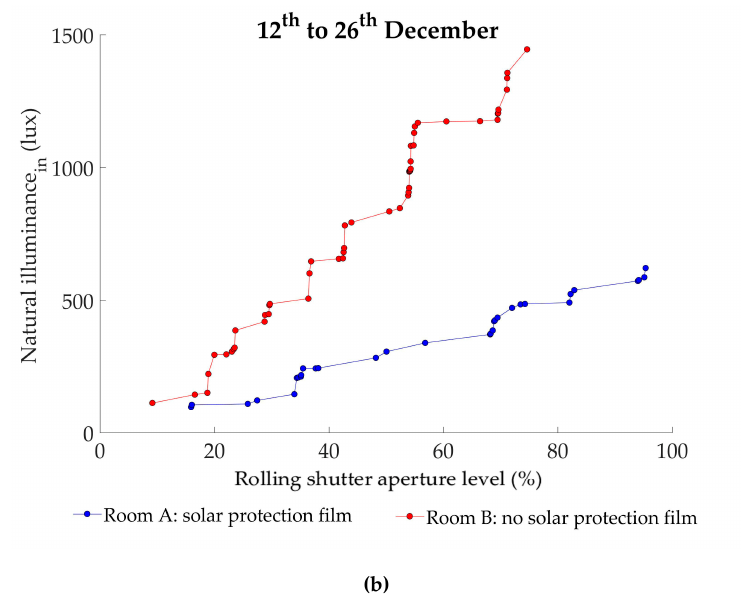
Figure 4. Winter period: ( a ) Outdoor and indoor natural illuminance; ( b ) Cumulative distribution of rolling shutter aperture levels (%) and indoor natural illuminance. Source: authors.